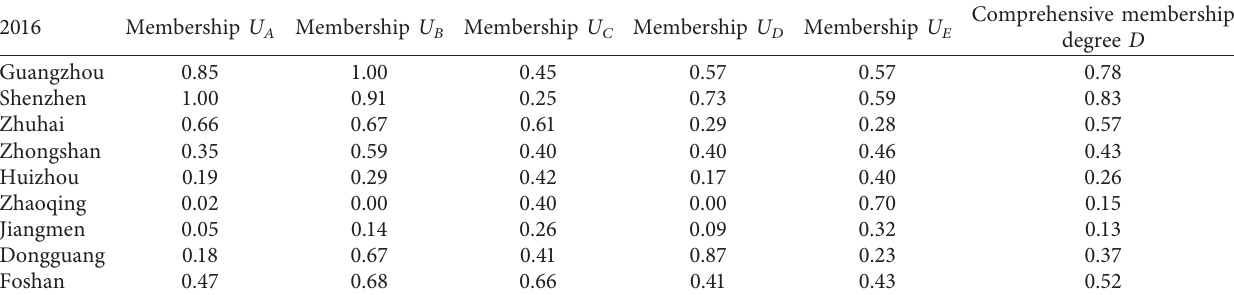
Table 15: First-level membership of the happiness index of nine cities in the Pearl River Delta in 2016. 2016